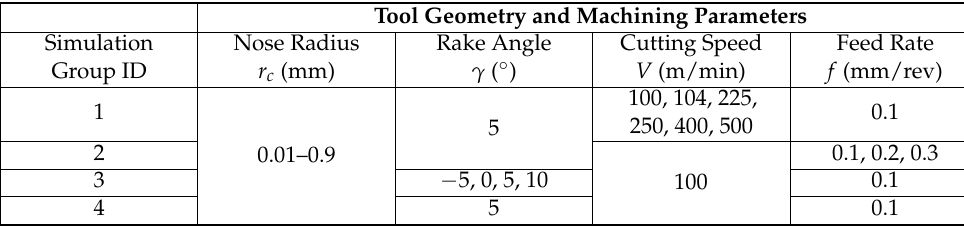
Table 3. Design for numerical